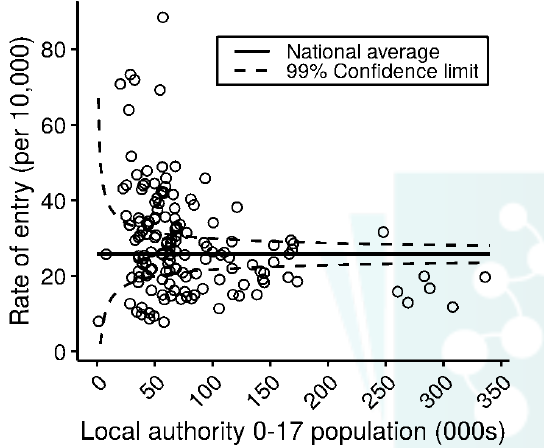
Figure 2: Number of parents and children entering public law proceedings over time and local authority variation in the rate of child entry into public law